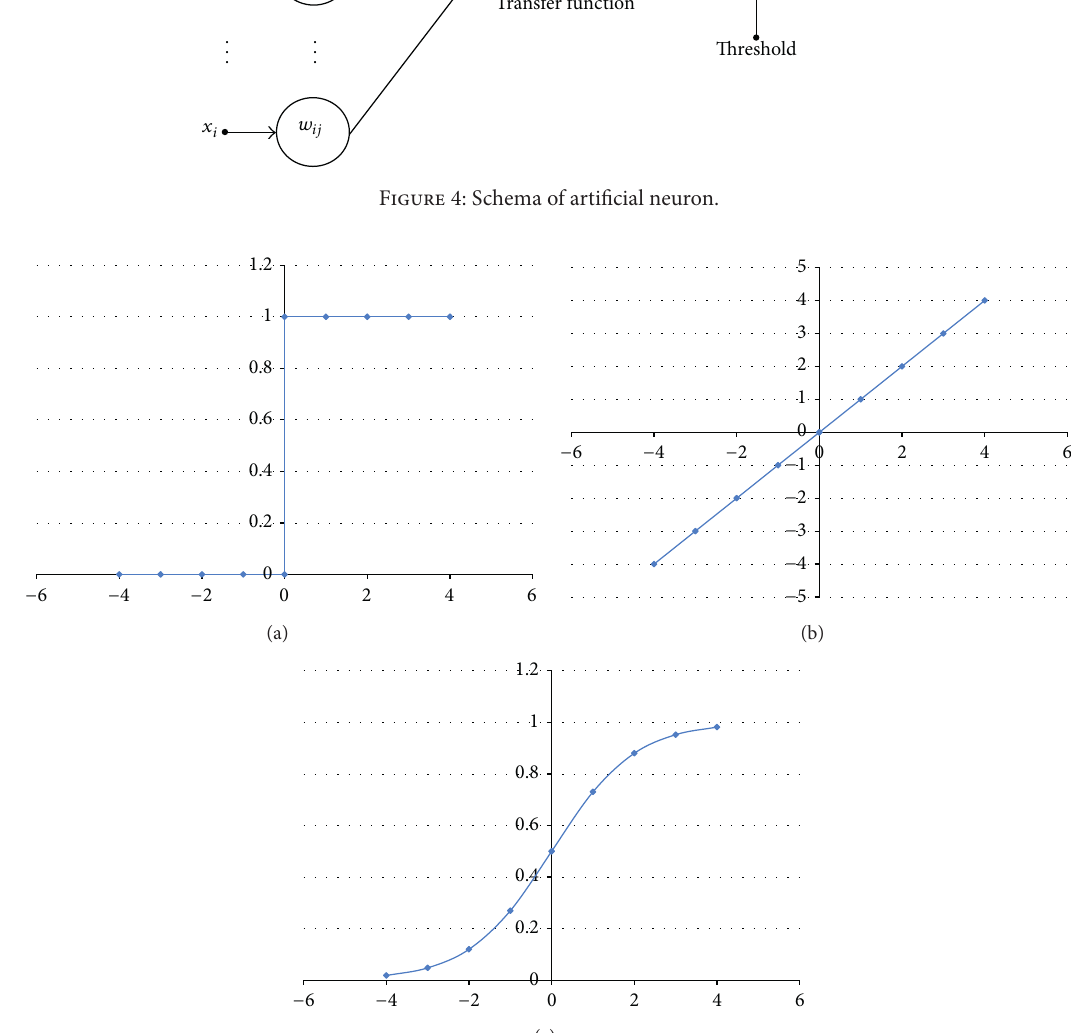
Figure 5: The most common activation functions: (a) step function; (b) linear function; (c) sigmoid